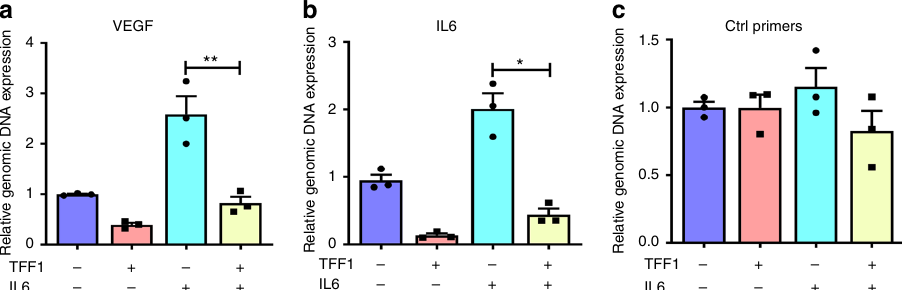
Fig. 6 ChIP assay con fi rms the decreased binding of STAT3 to its target genes after TFF1 reconstitution. a – c ChIP assay in AGS cells infected with control or TFF1 adenoviruses and stimulated with or without IL6 (100 ng mL − 1 ), followed by quantitative real-time PCR with primers designed for STAT3 binding site on VEGF ( a ) and IL6 ( b ) promoter regions and control primers ( c